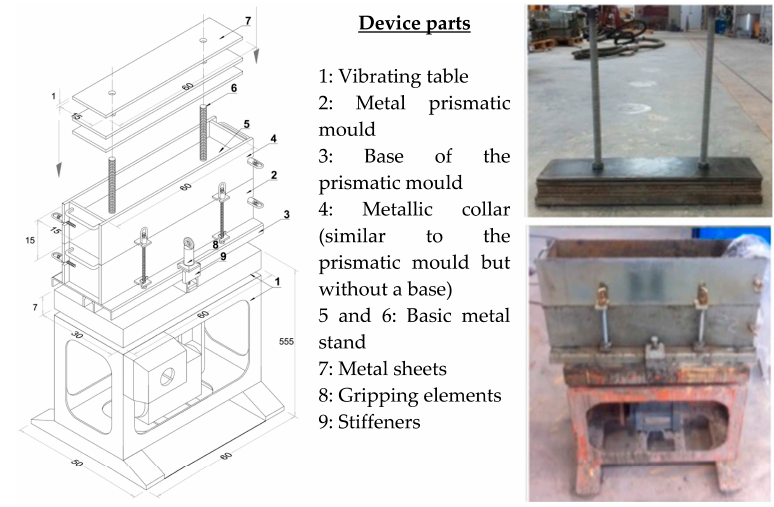
Figure 1. New device for compacting prismatic specimens. Units: cm.